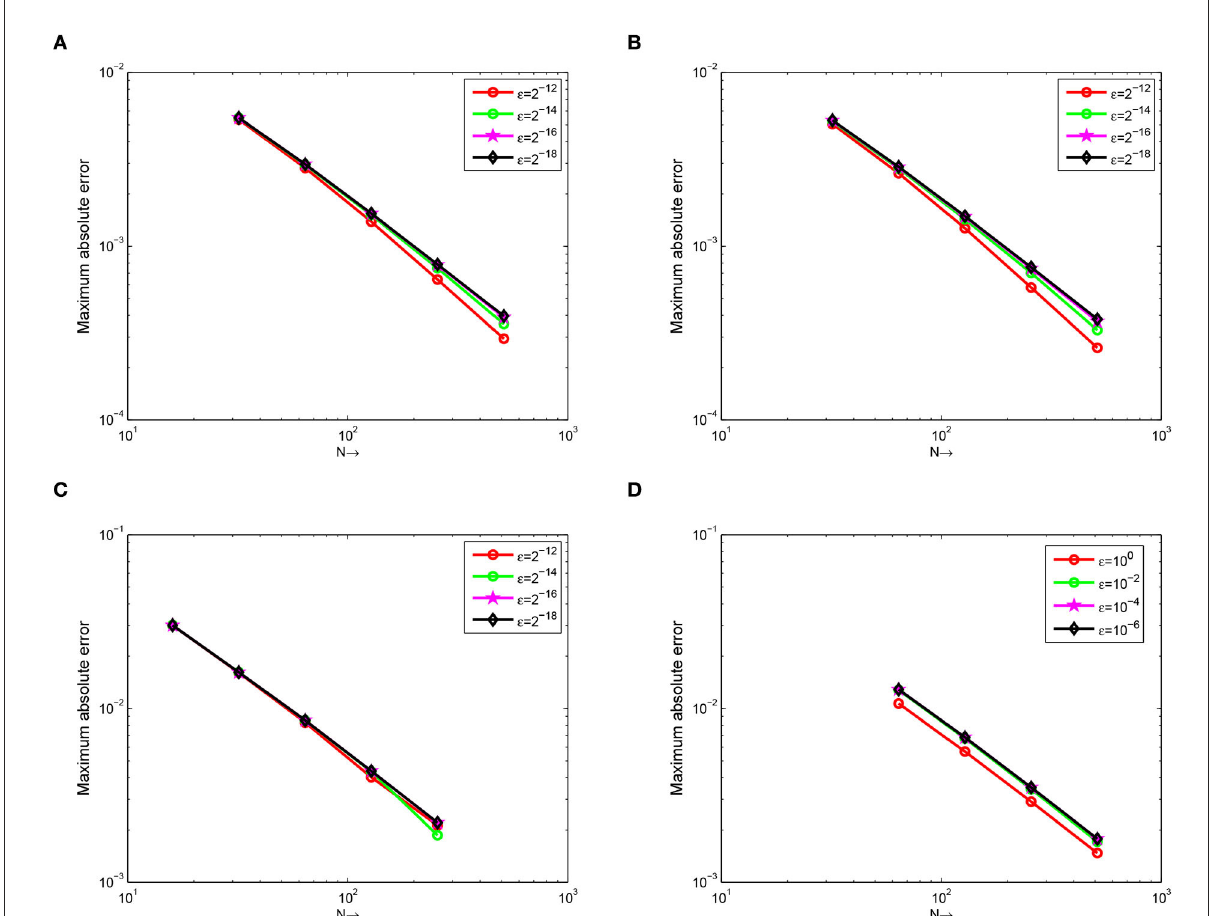
FIGURE4 Example 5.1 on (A) , Example 5.2 on (B) , Example 5.3 on (C) , and Example 5.4 on (D) , the error plot for different values of ε